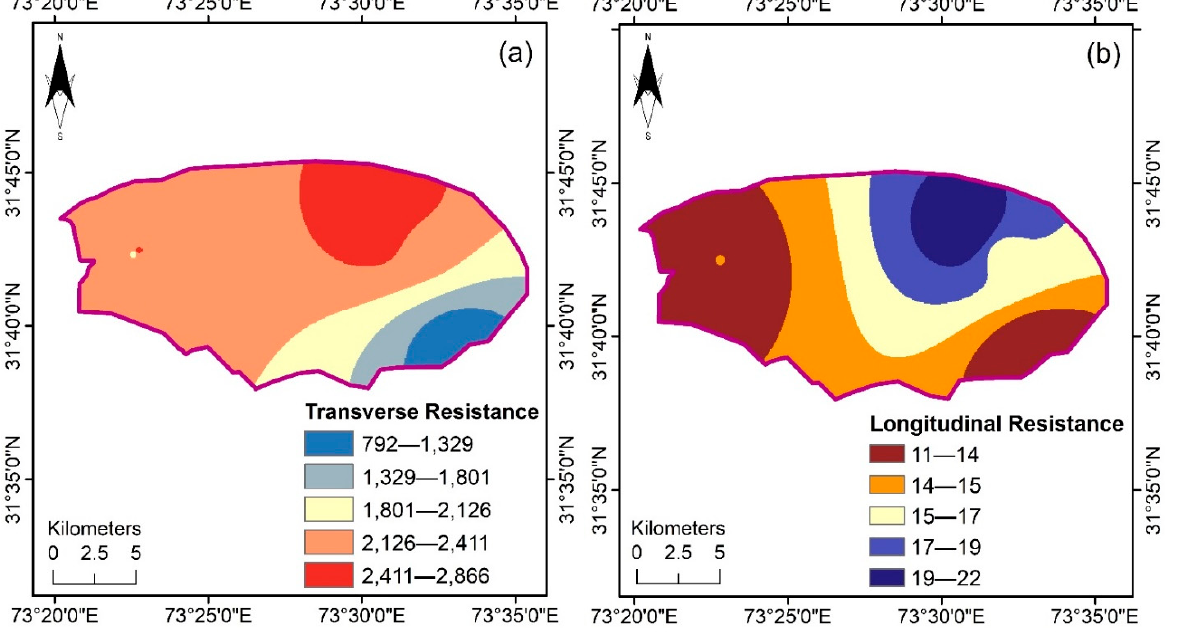
Figure 4. Geoelectrical Parameters: ( a ) transverse resistance and ( b ) longitudinal resistance.